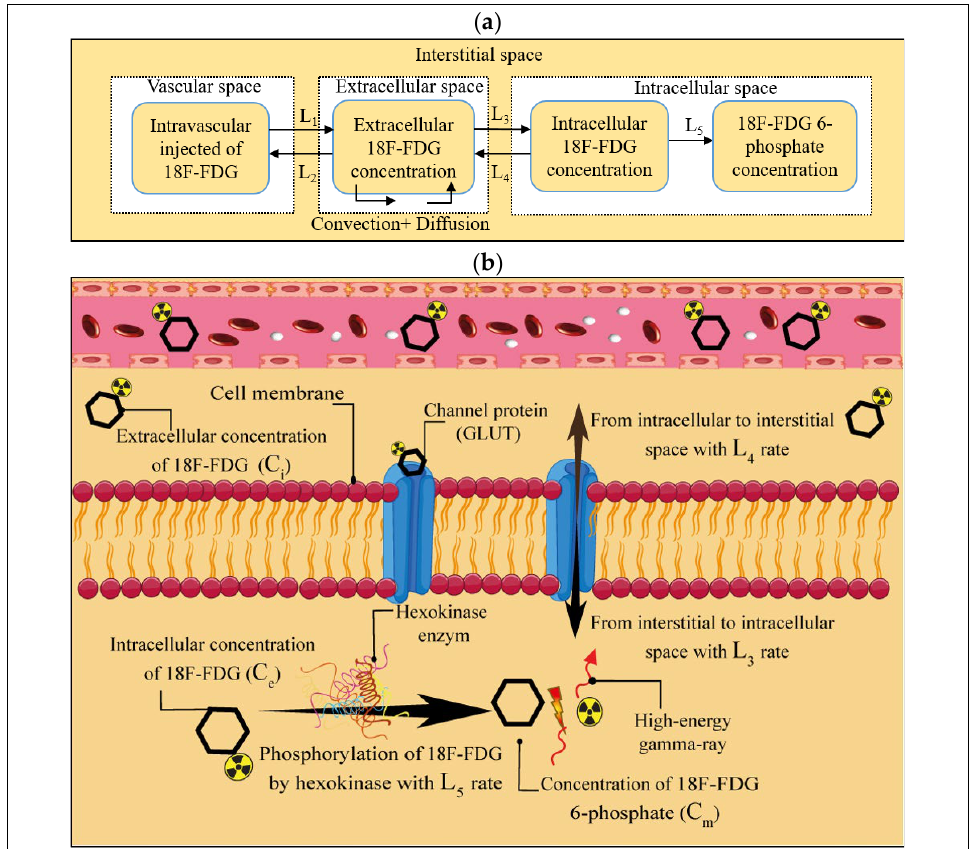
Figure 1. A schematic of the present multi-scale computational model of dynamic transport modeling of the 18F-FDG radiotracer. ( a ) Multi-compartment model of spatiotemporal distribution modeling of 18F-FDG radiotracer. ( b ) Schematic of exchanges of radiotracer between interstitium and microvessels via L 1 and L 2 coefficients, transport of extracellular radiotracer in the interstitial space through convection and diffusion mechanisms as well as entering the radiotracer into and out of the cell via L 3 and L 4 coefficients, and phosphorylation of intracellularly absorbed radiotracer by hexokinase enzymes via L 5 constant rate.